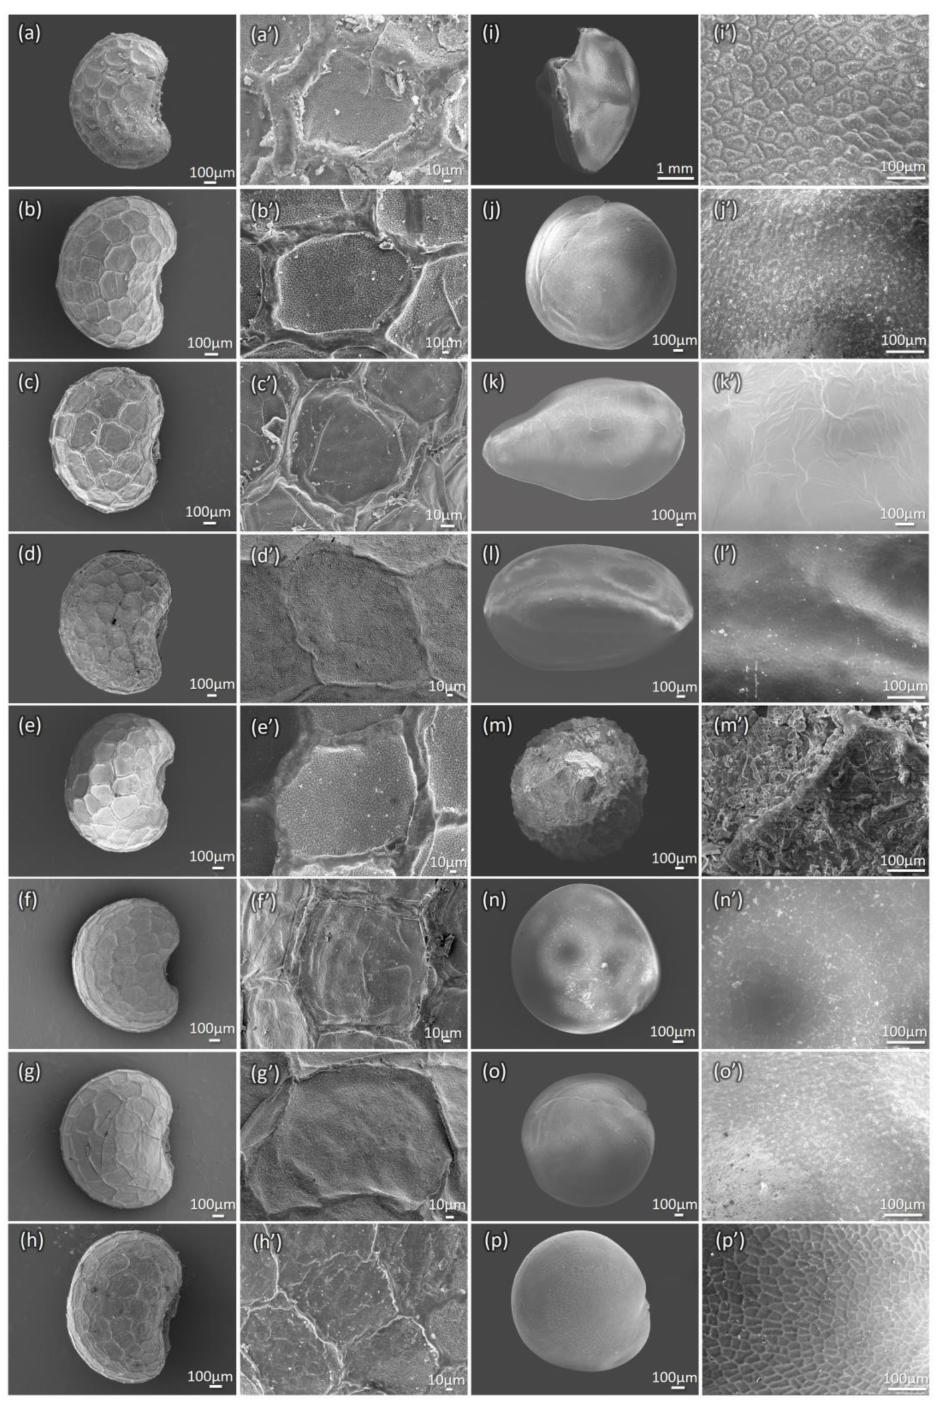
Figure 3. Scanning electron microscopy (SEM) observation of different poppy seeds. #24792 ( a , a’ ); #24790 ( b , b’ ); #25124 ( c , c’ ); #24793 ( d , d’ ); #24791 ( e , e’ ); #25107 ( f , f’ ); #16725 ( g , g’ ); and #5558 ( h , h’ ) show the whole seed view and testa texture with a reticulate waxy plate in blue/black/brown seeds and mild in white seeds. The adulterant samples: N. sativa ( i , i’ ) has a reticulate pattern of ridges with an ocellate spinulose testa texture; C. quinoa ( j , j’ ) has a “dusty” surface, with no protuberances; S. indicum ( k , k’ ) has a smooth texture with some nerve lines; S. hispanica ( l , l’ ) has a smooth texture; E. californica ( m , m’ ) has a rough and micro sculpted texture; A. cruentus ( n , n’ ), A. caudatus ( o , o’ ), are with smooth texture; A. paniculatus ( p , p’ ), has a reticulate somewhat hierarchically structure. Scale bars are marked respectively for each